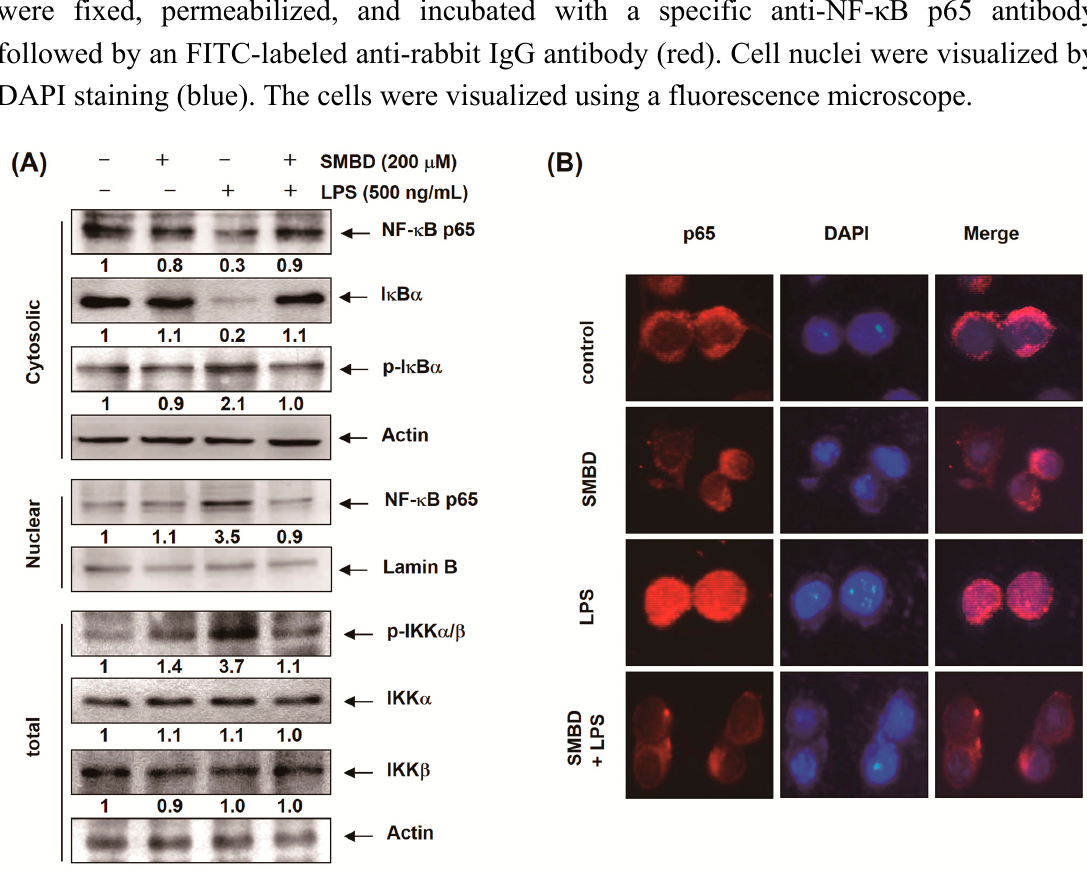
Figure 5. Effects of SMBD on the nuclear translocation of NF- κ B and degradation of I κ B- α in LPS-stimulated BV2 microglia. ( A ) BV2 cells were treated with 200 μ M